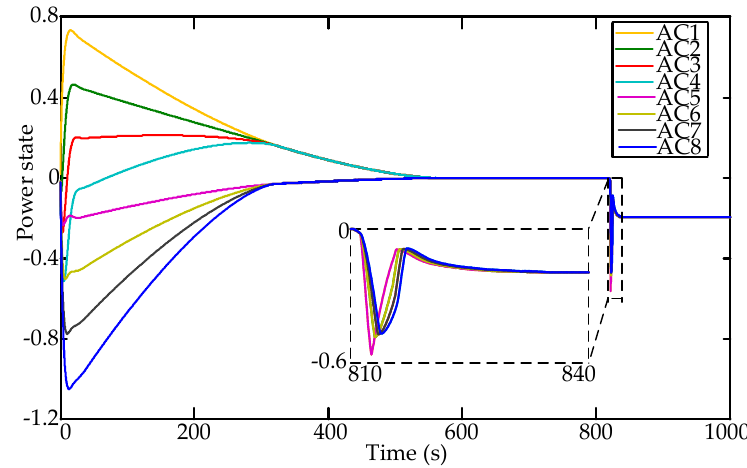
Figure 7. The power states of all individual ACs.